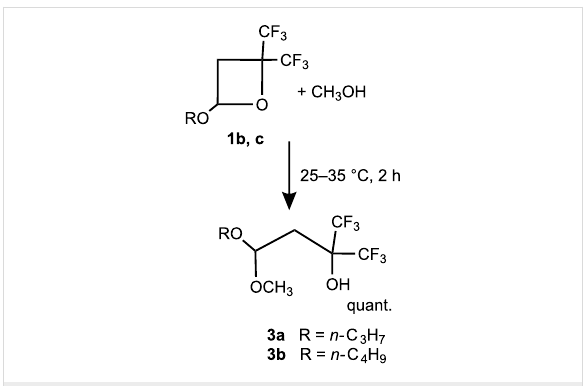
tion reactions are extremely rare and limited to two examples: